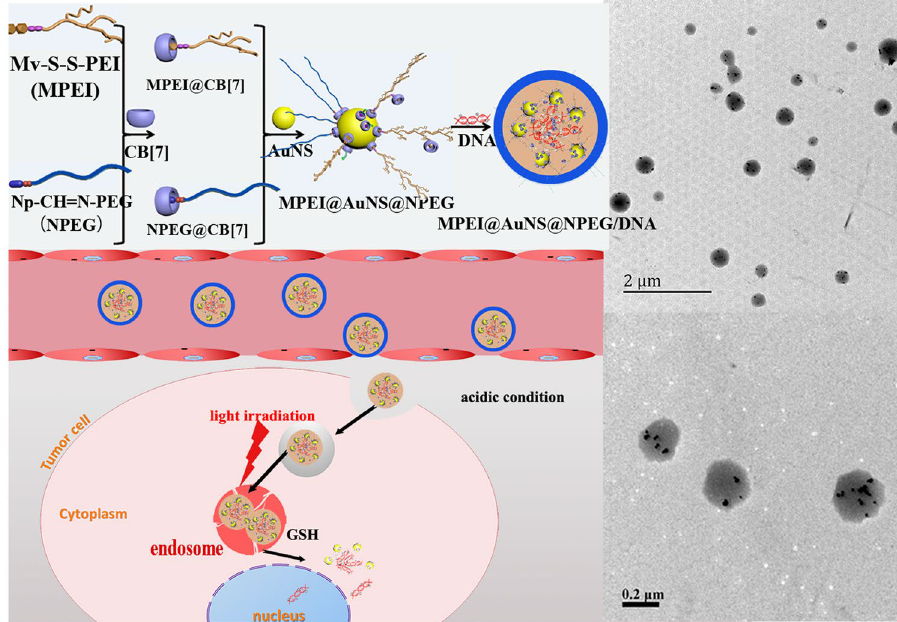
Figure 1. Schematic showing the assembling and delivery process (left) and TEM images (right) of MPEI@ AuNS@NPEG/DNA polyplexes.